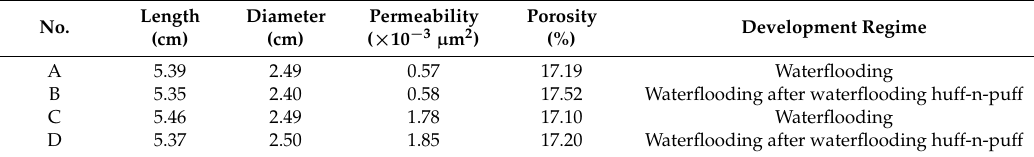
Table 1. Characteristics of the tight oil sandstone core